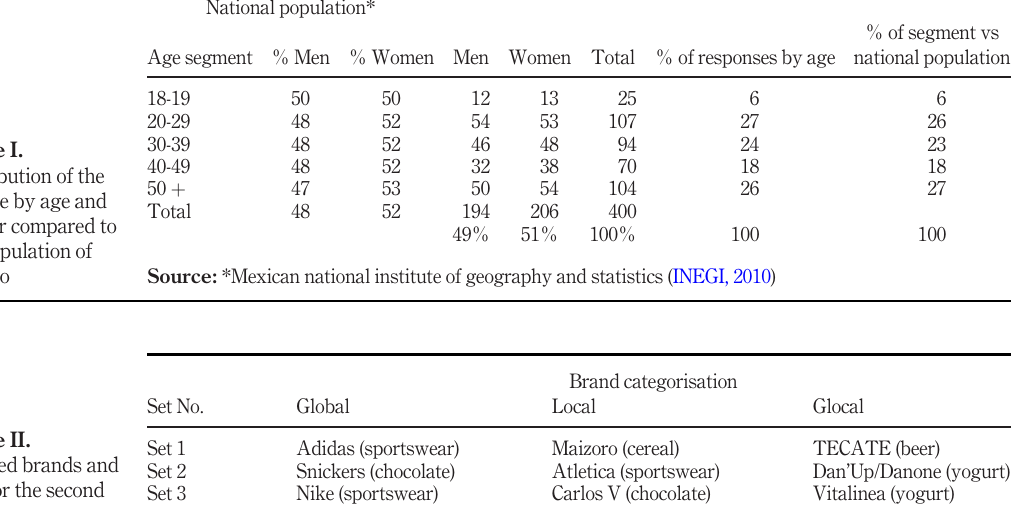
Table II. Selected brands and sets for the second survey